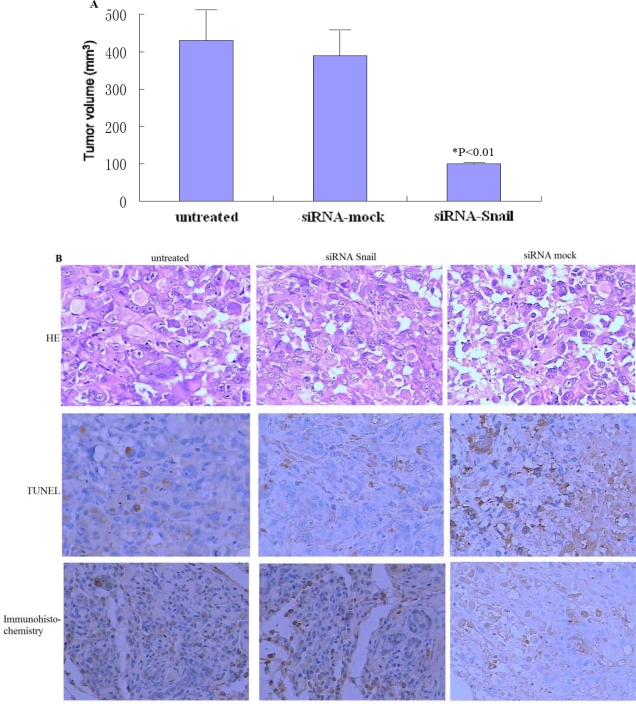
Knockdown of Snail suppresses the growth of xenograft pancreatic tumors. (A) PANC-1 tumors (n = 6 per group) were subjected to rAAV2-siRNA-Snail or rAAV2-siRNA-mock treatment for 21 days, as described in Materials and Methods. (B) Tumor histology was analyzed by H&E staining (top panel). Frozen sections of the PANC-1 tumors 48 hours after the second injection were analyzed by TUNEL to determine the level of apoptosis (middle). Snail protein expression levels were analyzed by immunohistochemistry (bottom). Magnification ×200.